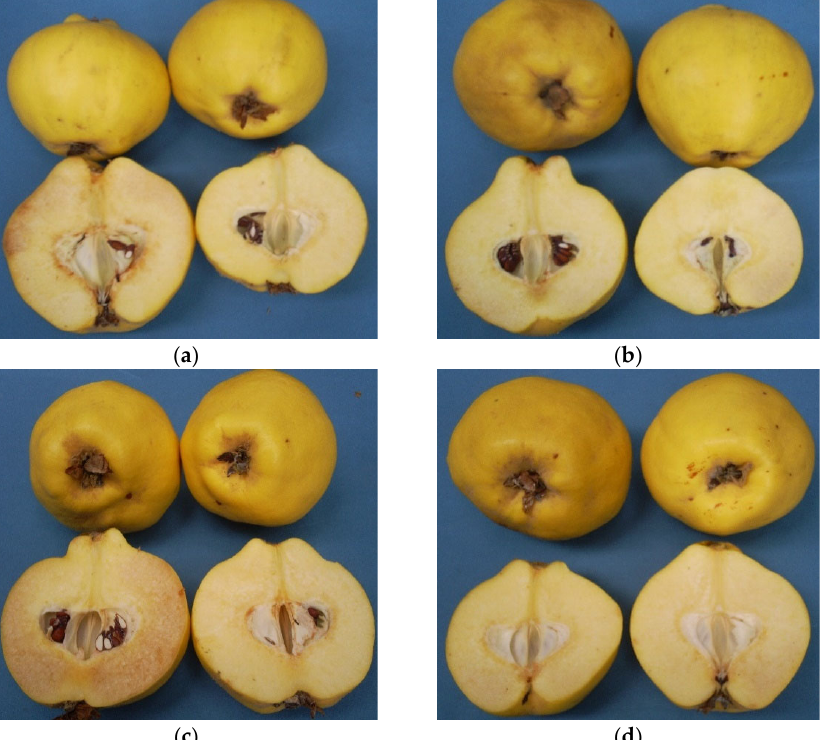
Figure 4. The appearance of quince fruit treated with different postharvest treatments after cold storage period of 6 months at 0 ± 1 °C, 85–90% relative humidity and regular air conditions. ( a )—Hot water treatment at 50 ± 1 °C for 3 min; ( b )—Hot water treatment at 50 ± 1 °C for 5 min; ( c )—300 ppb 1 ‐ methylcyclopropane (1 ‐ MCP) treatment at 12 °C for 20 h; ( d )—1000 ppb 1 ‐ MCP treatment at 12 °C for 20 h.